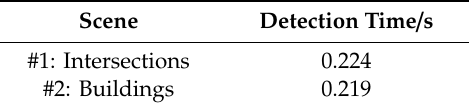
Table 6. Average single anomaly detection